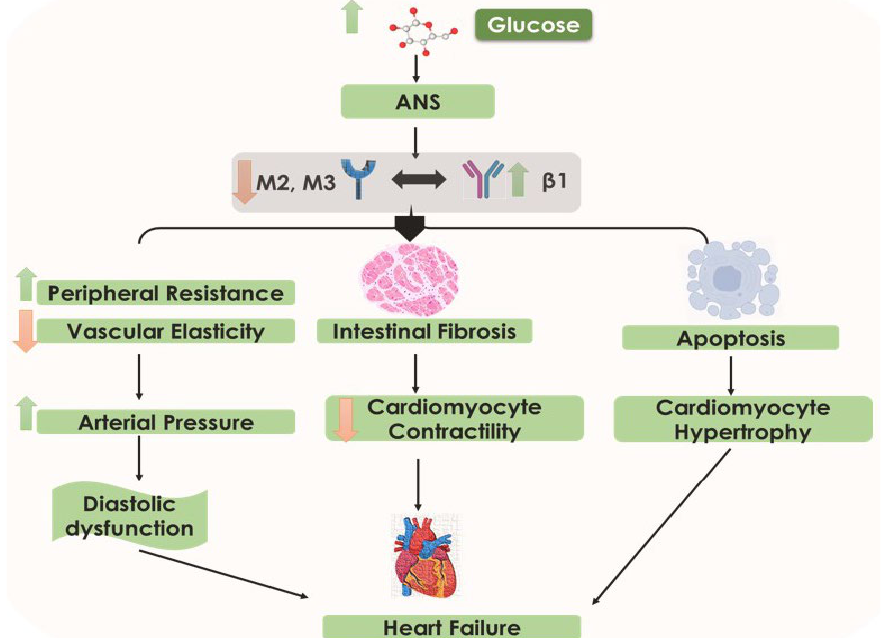
Figure 2. The sequence of events in diabetic heart failure. Increased glucose levels cause an increase in arterial pressure, decrease in cardiomyocyte contractility, cardiomyocyte hypertrophy, diastolic dysfunction, and heart failure. Arrows represent downstream